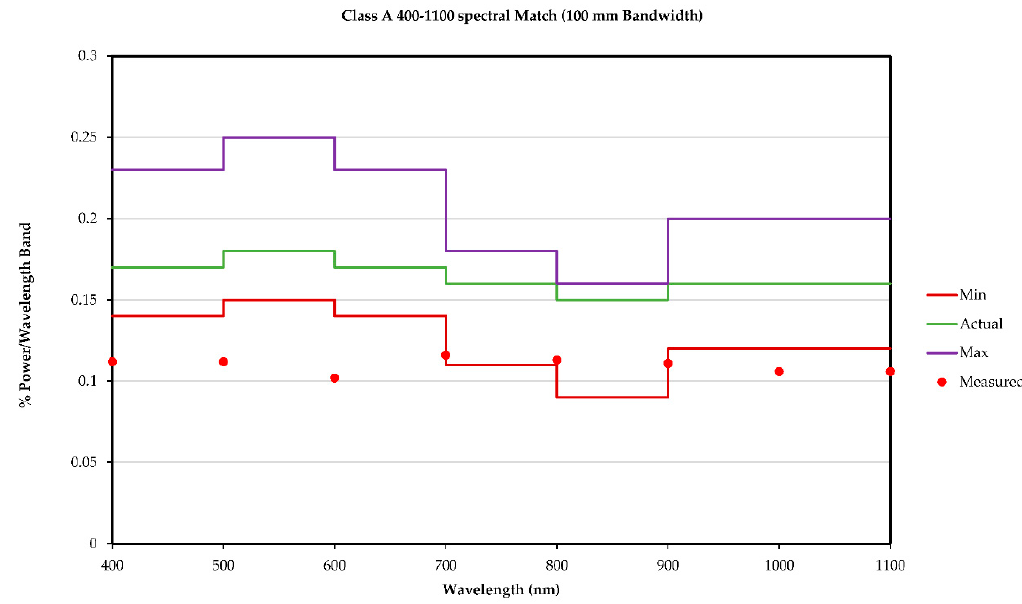
Figure 13. Spectral match of the characterised xenon arc lamp solar simulator.